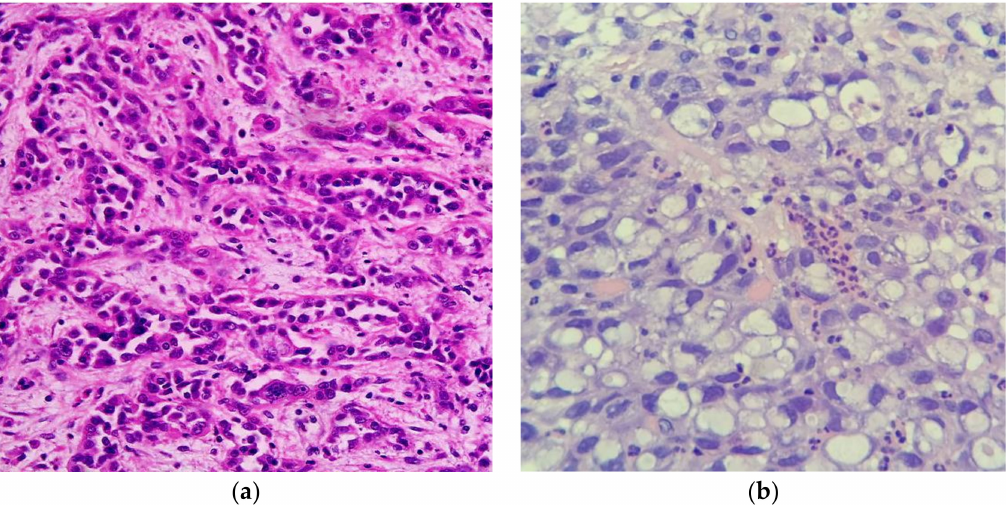
Figure 1. ( a ) Representative histological slide of poorly differentiated conventional gastric adenocarcinoma. ( b )Representativehistologicalslideofgastricsignetadenocarcinoma, illustratingmucin-filledcytoplasm with nucleus pushed to the periphery. Figures sourced from Wikimedia Commons, public domain